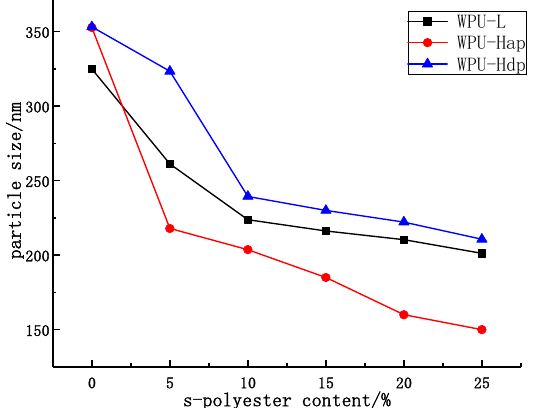
Figure 3. The particle size of the WPU-L, WPU-Hap, and WPU-Hdp emulsions.